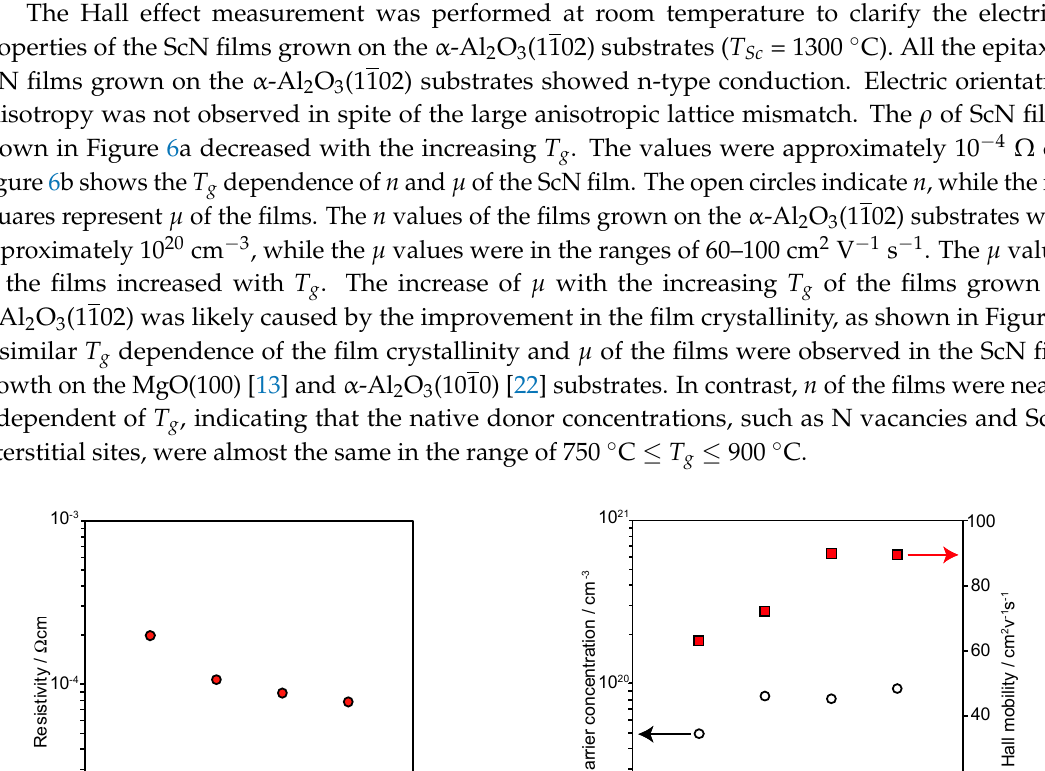
Figure 5. XRD ω -scan profiles for ScN(200) grown on the α -Al 2 O 3 (1102) substrates: ( a ) ScN films grown at 750 °C and ( b ) ScN films grown at 900 °C. The Sc source temperature is set to 1300 °C. The film thicknesses are in the range of 140–175 nm.